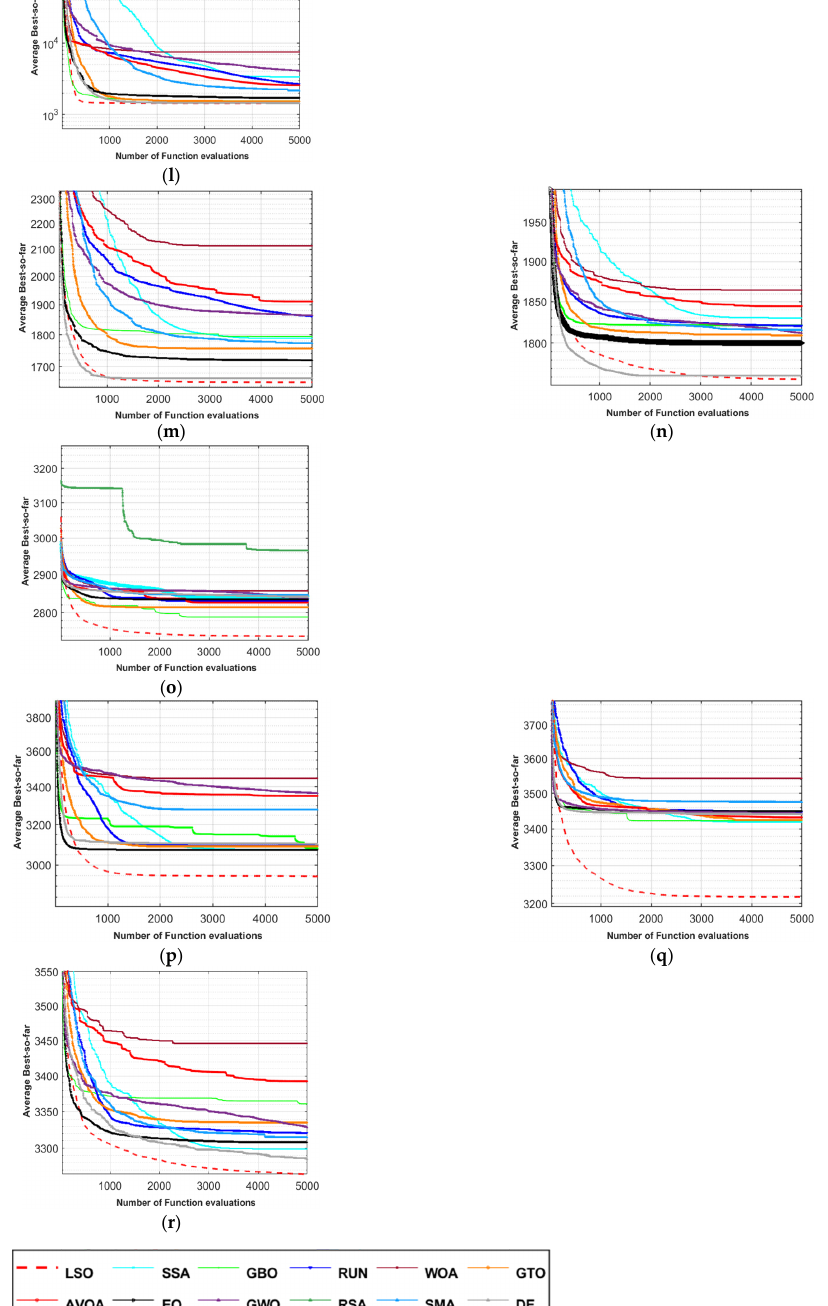
Figure 17. Depiction of averaged convergence speed among algorithms on some test functions. ( a ) F51 (Unimodal), ( b ) F52 (Unimodal), ( c ) F53 (Multimodal), ( d ) F54 (Multimodal), ( e ) F55 (Multi- modal), ( f ) F56 (Multimodal), ( g ) F57 (Multimodal), ( h ) F59 (Multimodal), ( i ) F60 (Multimodal), ( j ) F61 (Multimodal), ( k ) F62 (Hybrid), ( l ) F63 (Hybrid), ( m ) F65 (Hybrid), ( n ) F64 (Hybrid), ( o ) F73 (Composition), ( p ) F75 (Composition), ( q ) F77 (Composition), and ( r ) F78 (Composition).